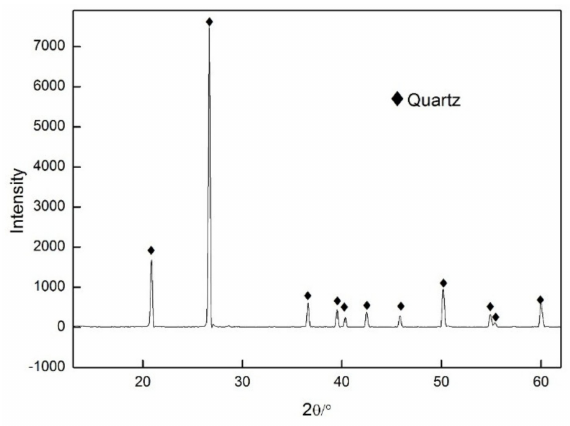
Figure 1. XRD pattern of